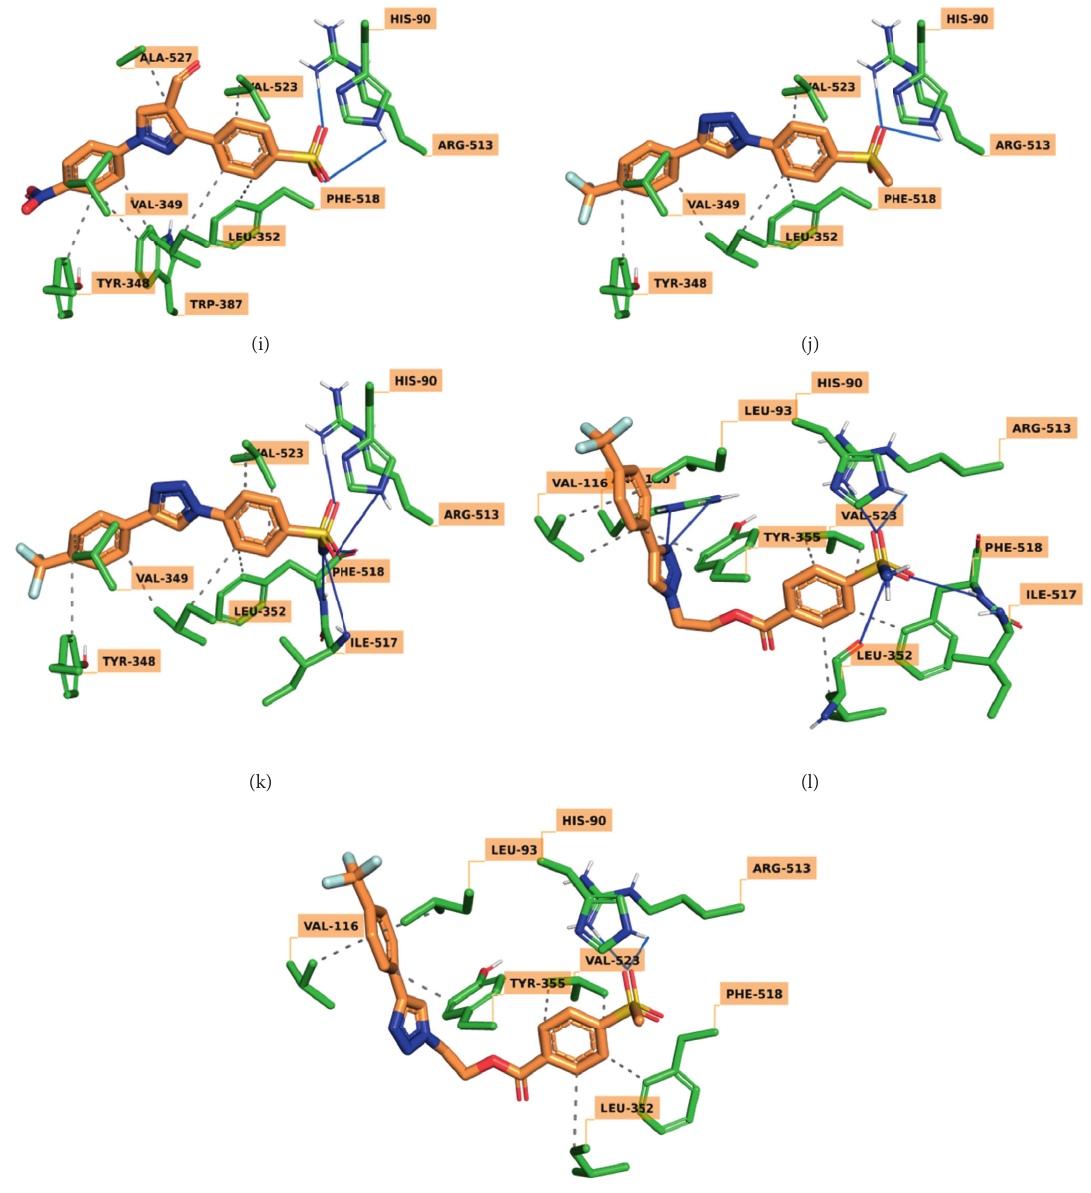
Figure 3: Crystal binding mode of (a) rofecoxib, and predicted binding orientations of (b) celecoxib, (c) 4a , (d) 4b , (e) 4c , (f) 4d , (g) 4e , (h) 4f , (i) 4g , (j) 8a , (k) 8b , (l) 15a , and (m) 15b visualized in COX-2 active site (PDB code 5KIR [32]); ligands are shown in orange and amino acids are shown in green. Only the interacting residues and their interaction patterns are